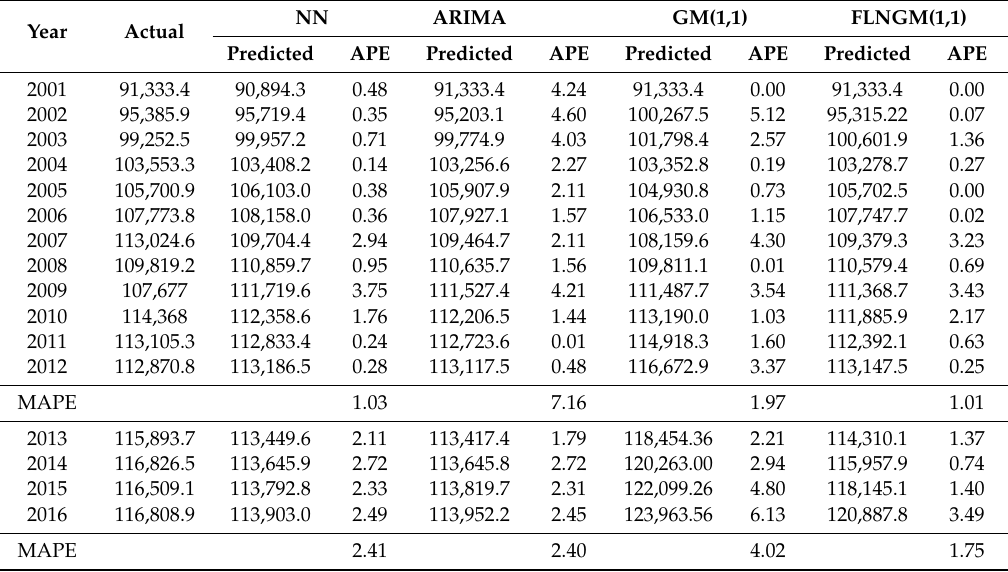
Table 4. Forecasting accuracy of di ff erent prediction models for Case II (unit: 104